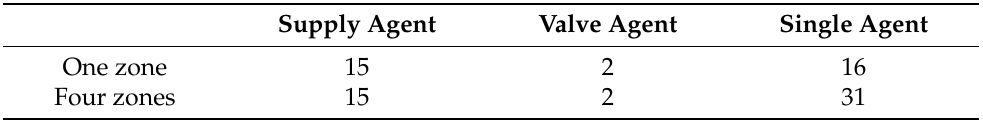
Table 5. Overview of how the input states are increasing when more zones are added to the system and how MARL and SARL are affected by